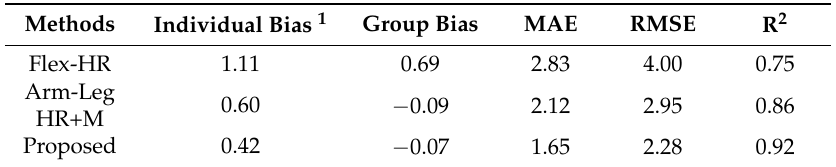
Table 6. Comparison of VO 2 estimation results among flex-HR, arm-leg HR+M, and proposed method (mL/kg/min).